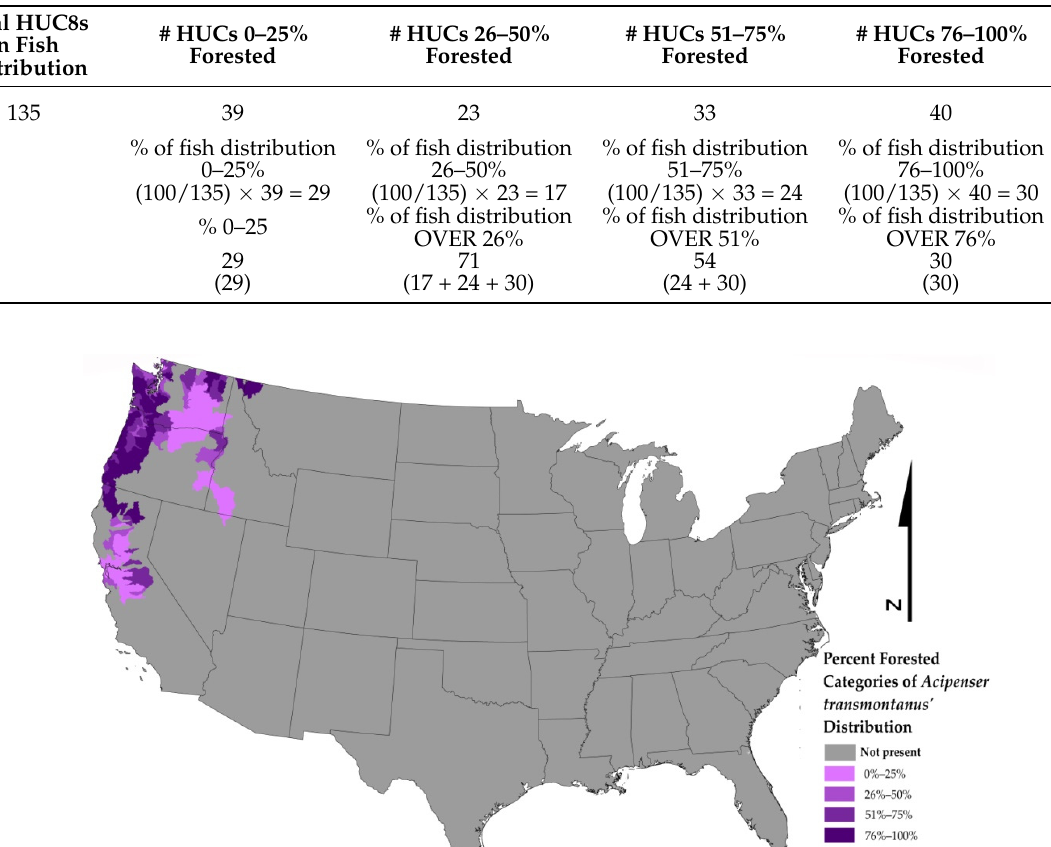
Table A3. Single species example of how percent was calculated for different combinations of forested land area in the total distribution of an individual species. The top rows are a count of the number of HUC8s in the distribution of White Sturgeon Acipenser transmontanus that fall into the four forested categories. Below are the percent of the distribution in each forested category, and at the bottom, the “over” categories where 25, 50, and 75% distribution in forested was combined to make the “over 25”, and the “over 50%” was found by combining 50 and 75%.